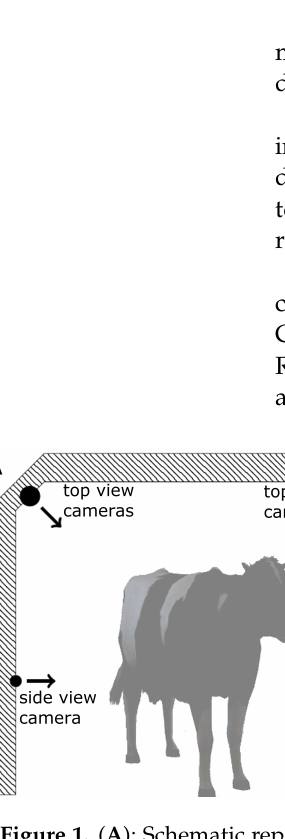
Figure 1. ( A ): Schematic representation of the framework with the positions and lines of sight of the side view and top view Kinect cameras shown as black bullets and arrows. ( B ): Technical drawing of a pair of top view Kinect cameras, fixed with 56 ◦ angle between the fronts. In the foreground, the bottom of a Kinect base is seen as pointing away from the pair. ( C ): Combined horizontal field of view of all four top view cameras.